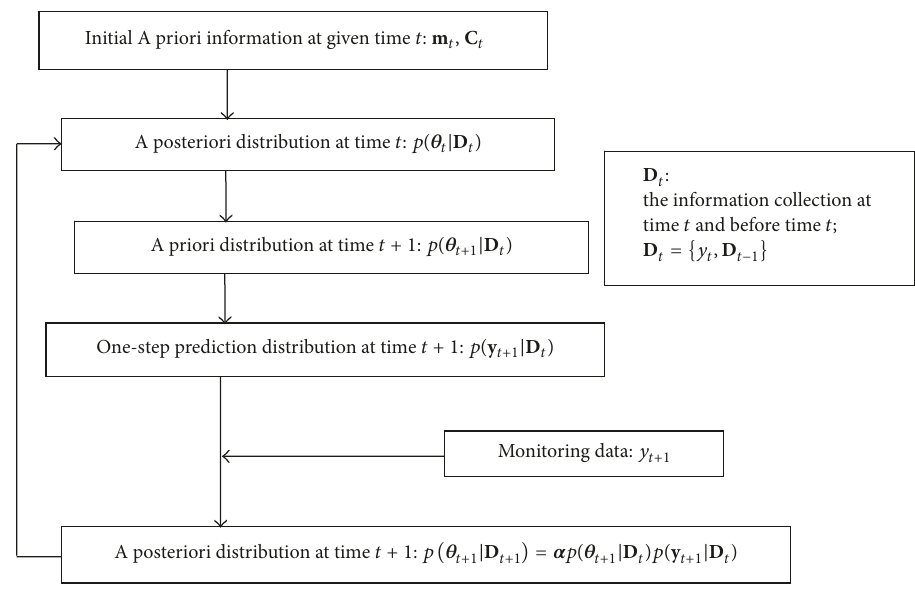
Figure 2: The probability recursive processes of